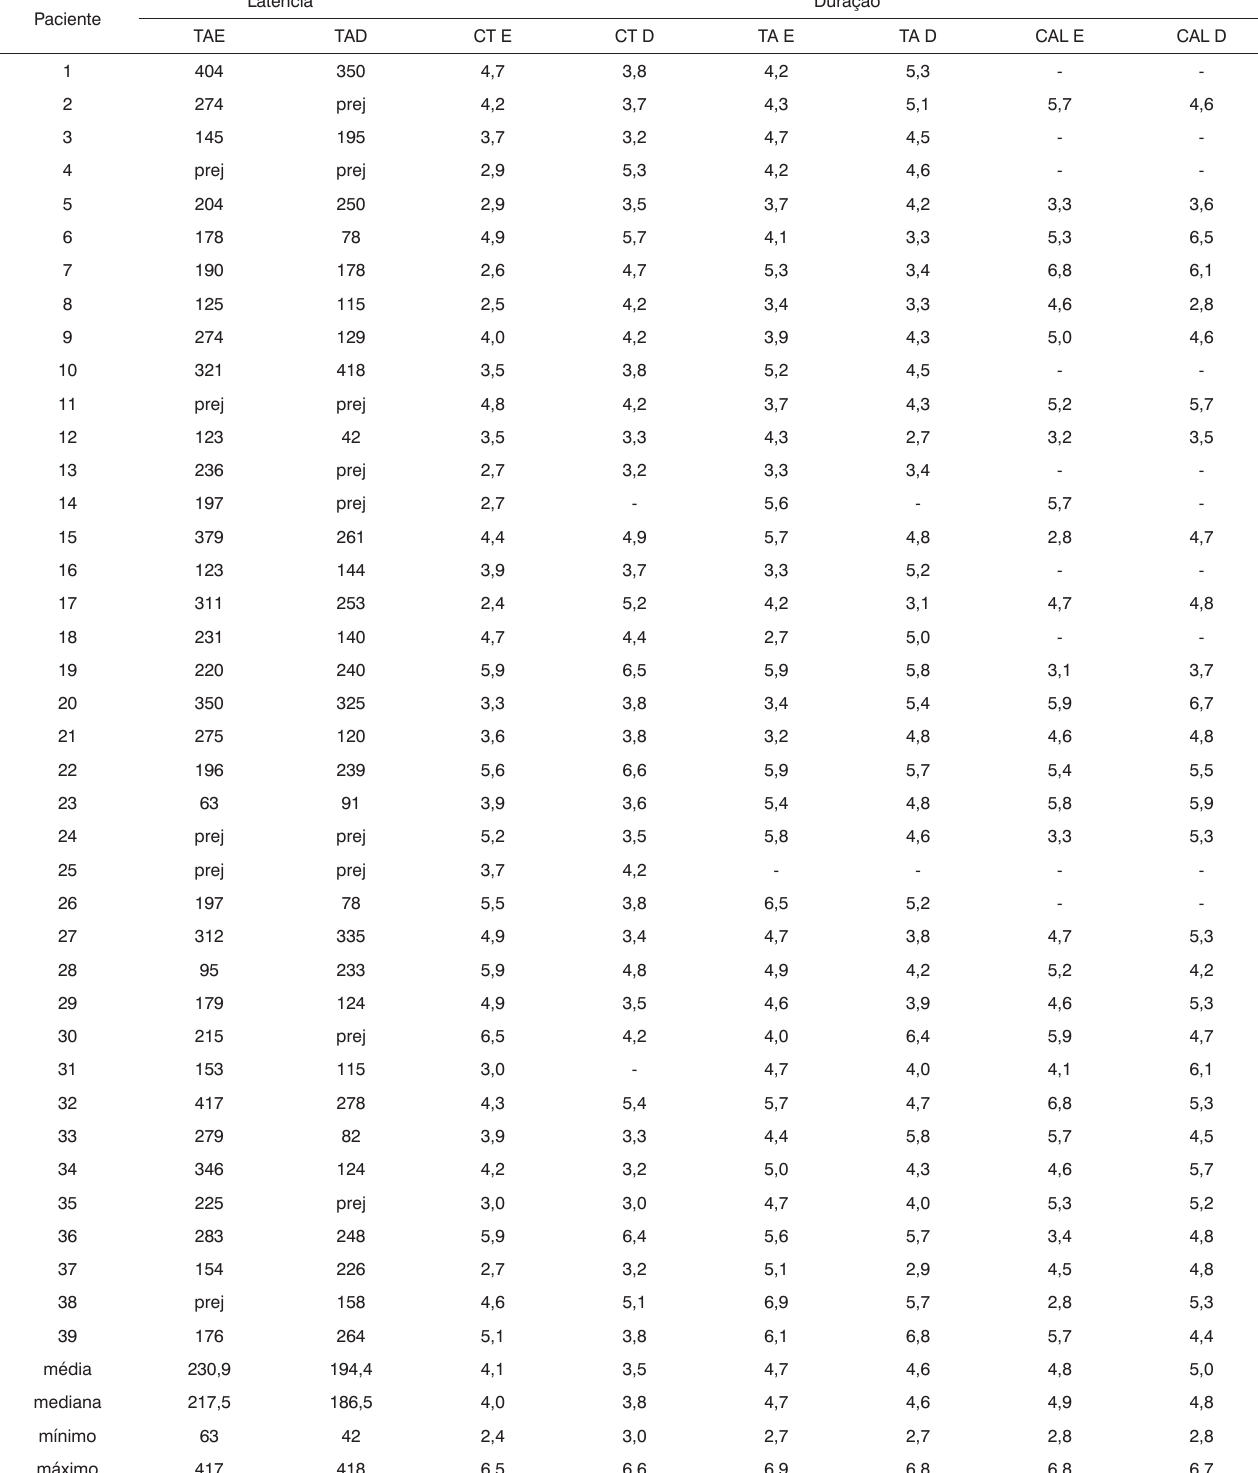
Tabela 1. Tempo de latência entre a atividade eletrofisiológica e o início da sonorização em ms e duração do potencial de unidade motora nos músculos examinados em